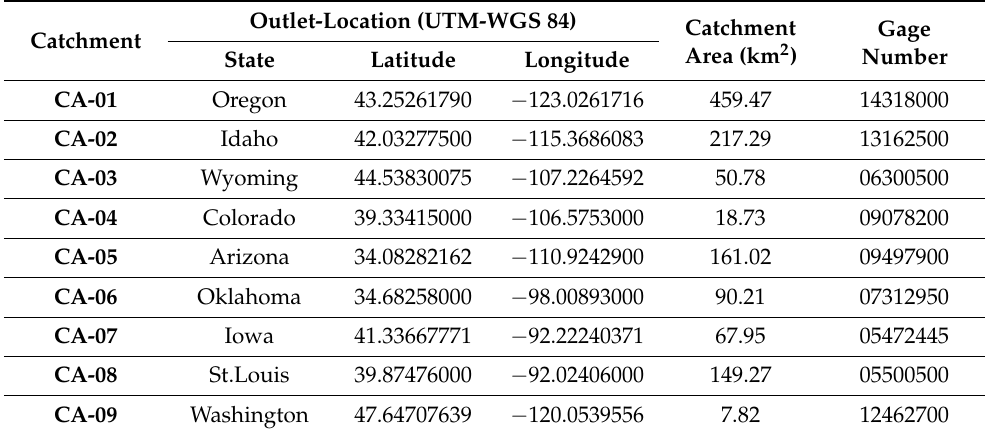
Table 6. Locations and areas for the selected catchments.